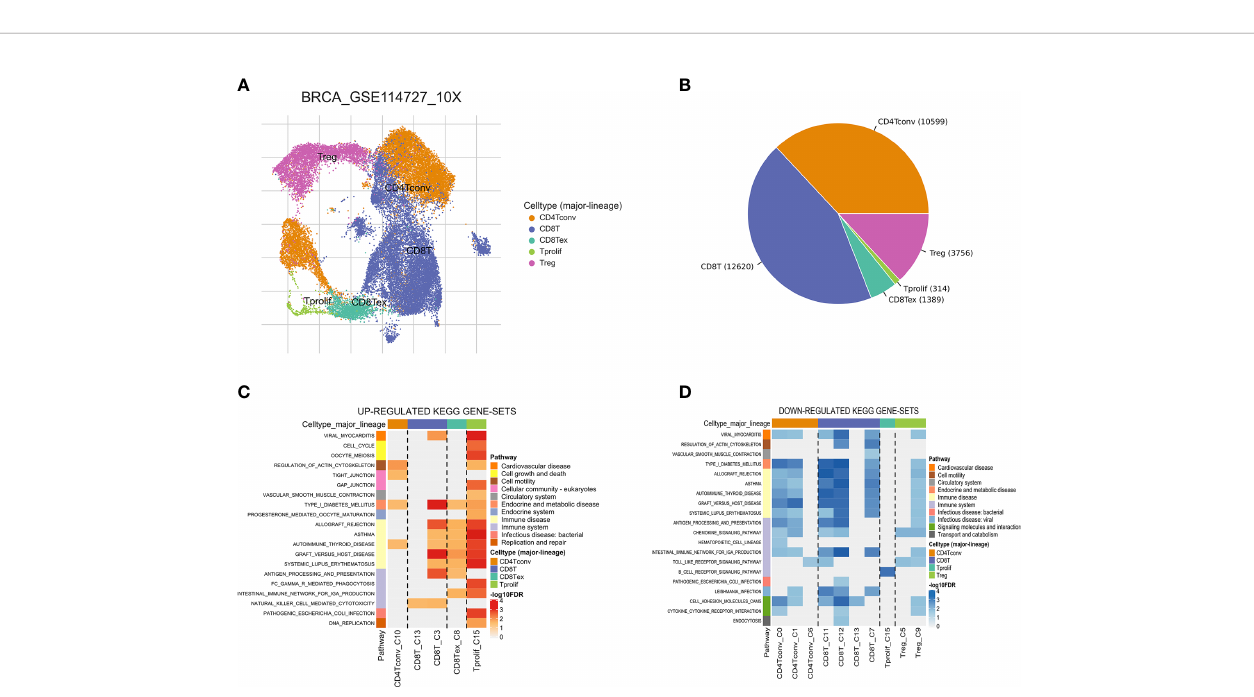
FIGURE 3 | Breast cancer single-cell data analysis based on the GSE114727 dataset. (A) UMAP plots with cells colored by cell type are displayed. (B) The pie plot shows the cell number distribution of each cell type. Heatmap showing enriched up- (C) or down-regulated (D) pathways identi fi ed based on differential genes in each cell type.